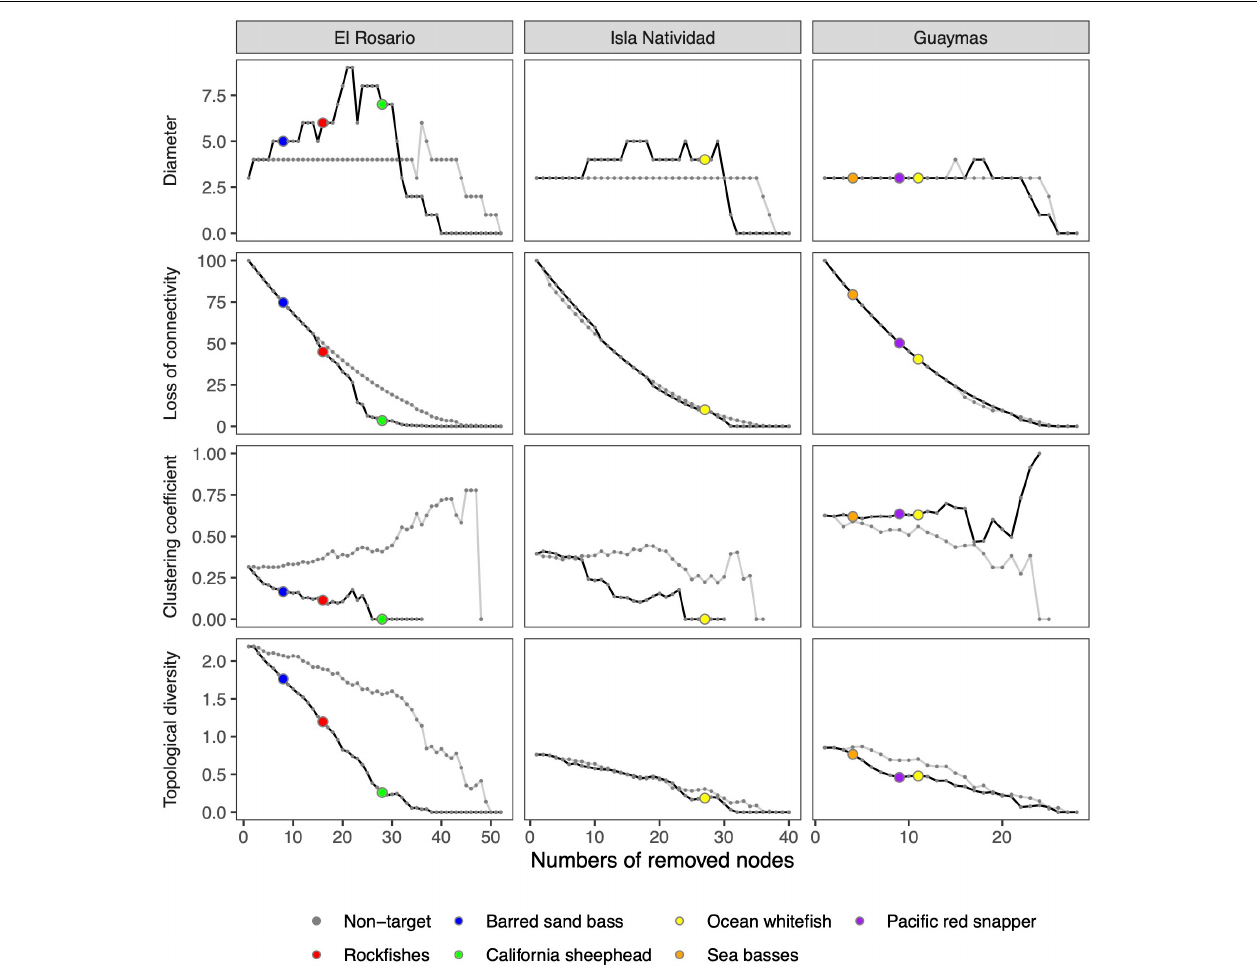
FIGURE 2 | Changes in food web indicators in El Rosario, Isla Natividad, and Guaymas as a consequence of removing nodes (functional groups) based on two scenarios: random failures (gray lines) and directed impacts (black lines). In the directed impacts scenario, non-target species are indicated by gray dots, and target species are indicated by different colors.